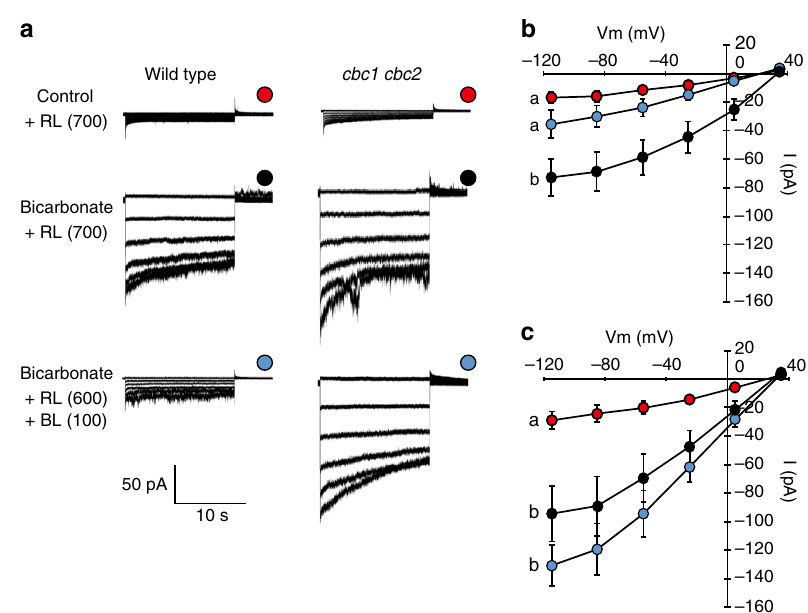
Fig. 3 The inhibition of bicarbonate-activated S-type anion currents by BL is abolished in Arabidopsis guard cells from the cbc1 cbc2 mutant. a Representative whole-cell currents of WT and cbc1 cbc2 . b , c Whole-cell outward S-type anion current – voltage relationships in GCPs of WT ( b ), and cbc1 cbc2 ( c ). The data are presented as means ± s.e.m. (WT control RL, n = 7; WT bicarbonate RL, n = 7; WT bicarbonate RL + BL, n = 6; cbc1 cbc2 control RL, n = 8; cbc1 cbc2 bicarbonate RL, n = 7; cbc1 cbc2 bicarbonate RL + BL, n = 5). Signi fi cant differences are denoted with different lowercase letters. GCPs were irradiated with RL (600 μ mol m − 2 s − 1 ) and treated with or without 1.2 mM bicarbonate buffered to 1 mM free CO 2 (pH 5.6). To measure BL-dependent S-type